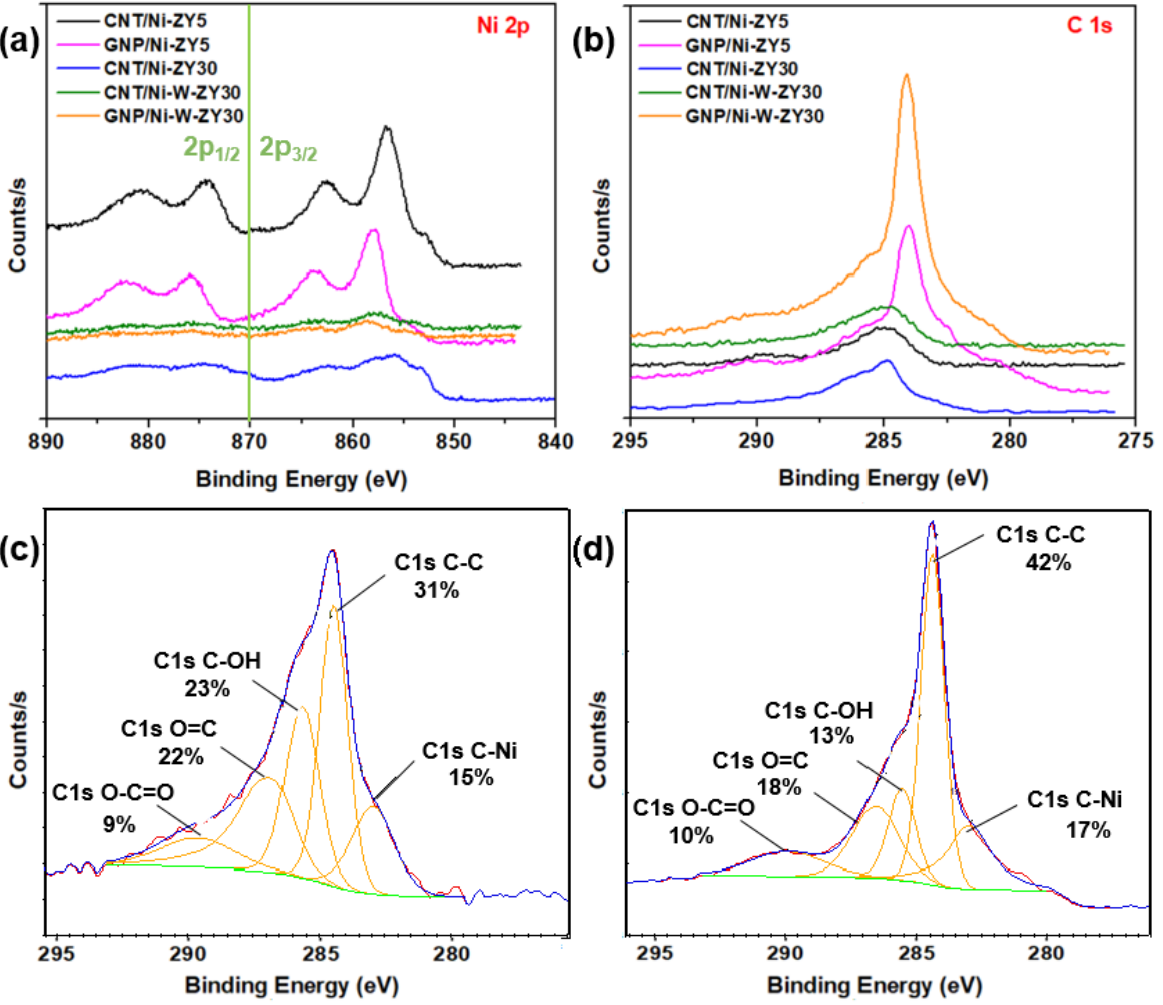
Figure 6. XPS core level spectra: ( a ) Ni 2p and ( b ) C 1s for the prepared catalysts, including peak fits showing the presence of the sp 2 hybridized carbon in ( c ) CNT/Ni ‐ ZY30 and in ( d ) GNP/Ni ‐ ZY5. Effect of Si/Al ratio in zeolite support: The Si 2p, Al 2p, and O 1s peaks (not shown in